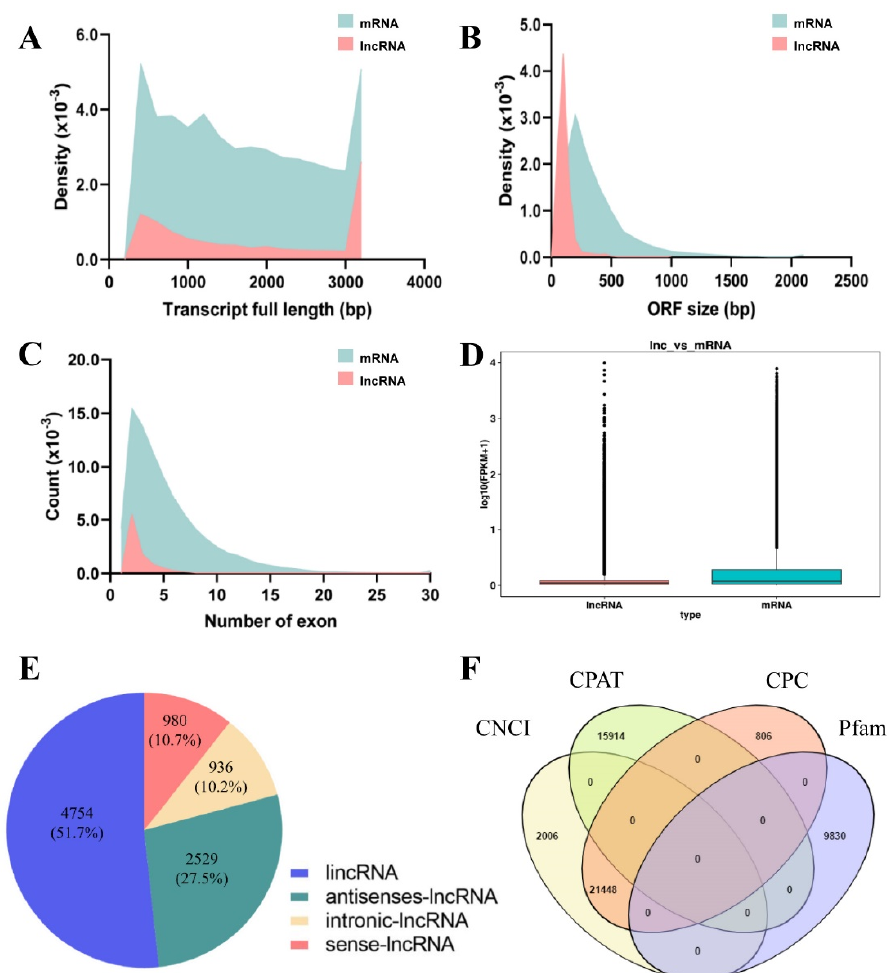
Figure 2. Identification and characterization of lncRNAs in Panonychus citri. ( A ) Full length distribution of lncRNAs and mRNAs in the mite P. citri . ( B ) Maximum open reading frame (ORF) size distribution of lncRNAs and mRNAs in the mite P. citri . ( C ) Number of exons per transcript for lncRNAs and mRNAs. ( D ) Overall expression (log 2 (FPKM+1)) of lncRNAs compared with mRNAs in P. citri . ( E ) lncRNA categories and their proportions. ( F ) Venn diagram of lncRNAs by different prediction methods. CNCI: Coding-Non-Coding-Index; CPAT: Coding Potential Assessment Tool; CPC: Coding Potential Calculator; Pfam: Pfam database.